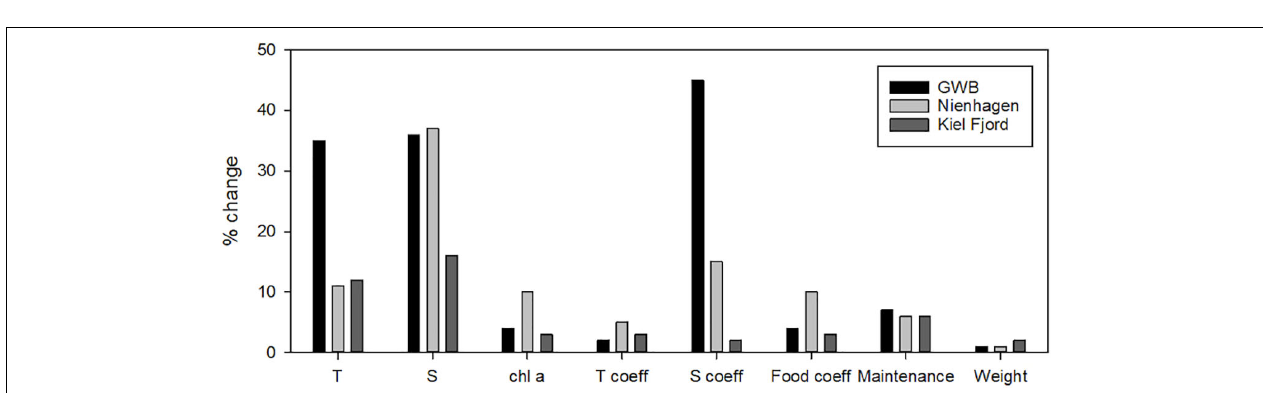
FIGURE 2 | Upper graphs: Model results from the four study sites Kiel (green), Nienhagen (yellow), WB (red), and GWB (orange) compared with measured data for SL and tissue DW. Lower graphs: water temperature, chl-a concentration and salinity at study sites during the study period (monitored data of LLUR and LUNG).